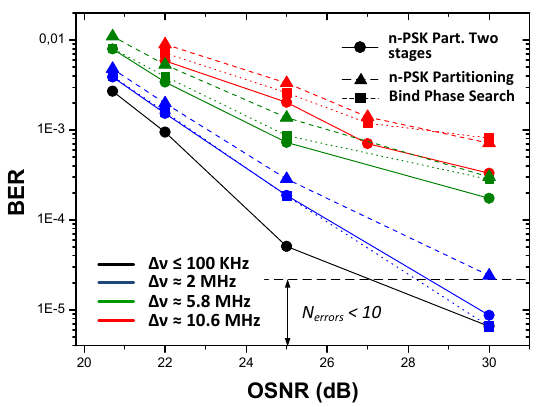
Figure 7. BER versus OSNR curves of a 28-Gbaud C-16QAM back-to-back transmission employing different CPR algorithms for different laser linewidths. N errors : Number of errors.